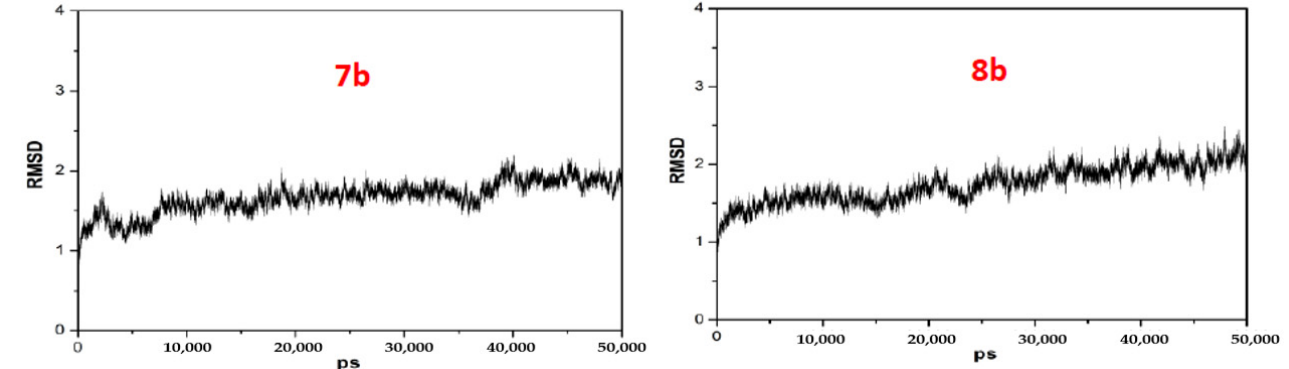
Figure 5. The RMSD value of compound 7b and 8b .